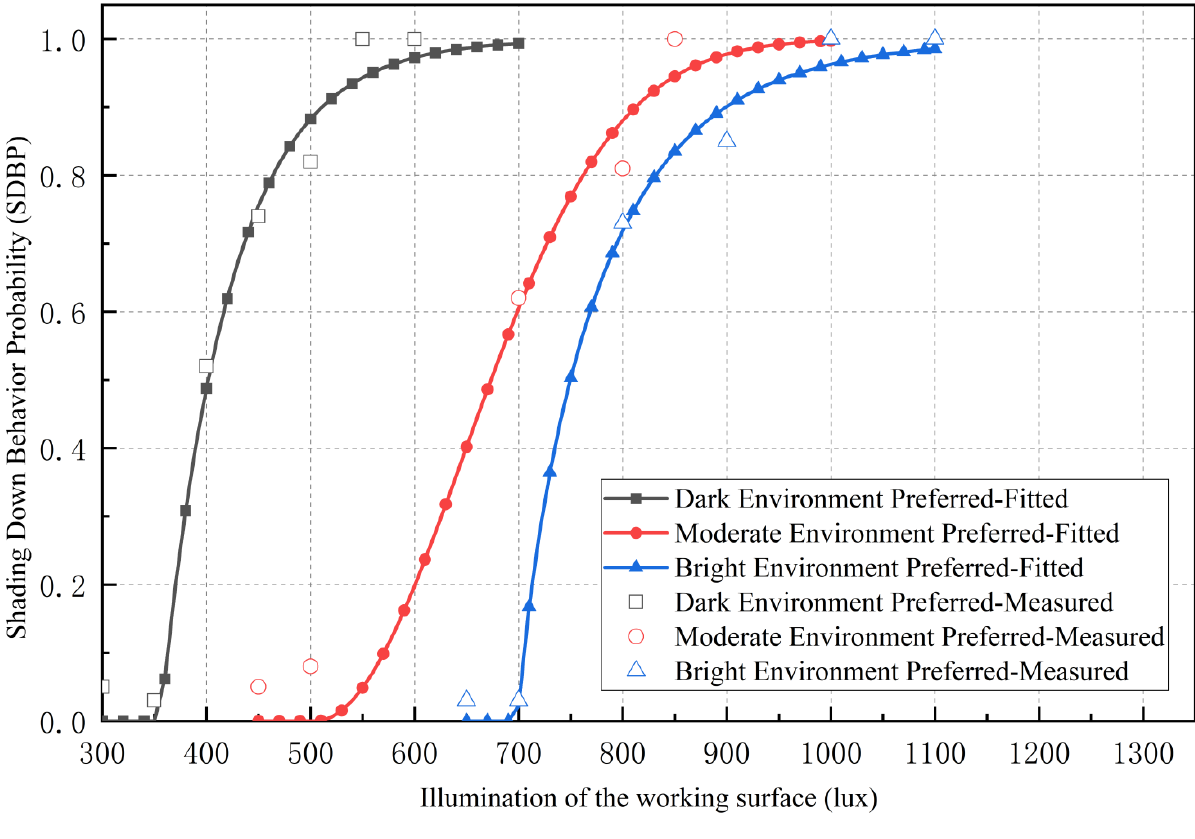
Figure 13. Surface illumination conditions. Table 8. Probability fitting equation for the shading behavior of different occupant types.